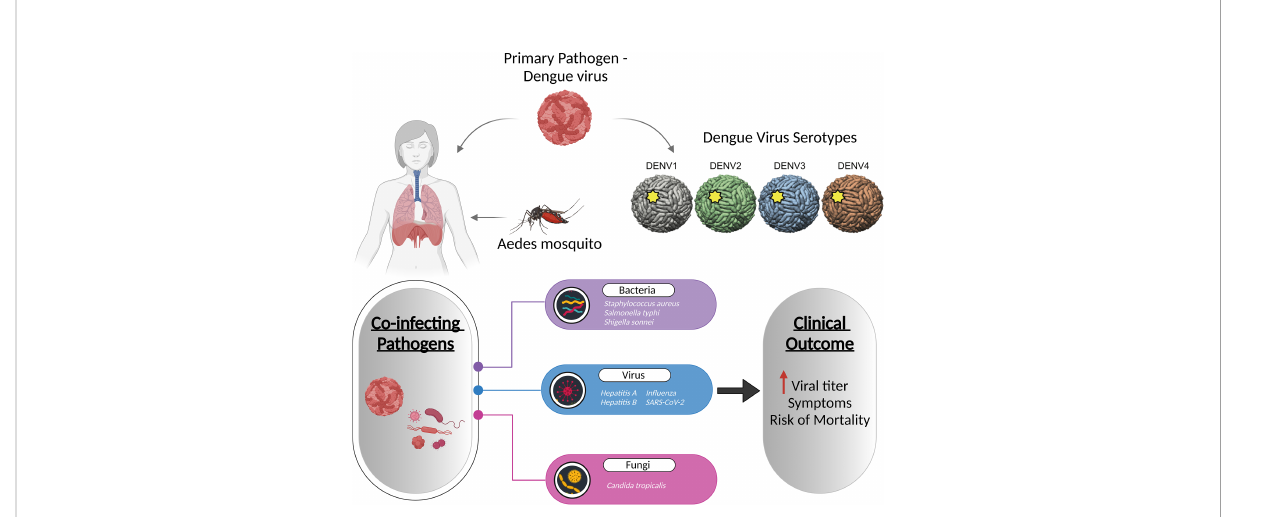
FIGURE 4 Co-infection of dengue with viruses, bacteria, and fungi increases the dengue viral titre, and even increases the symptoms and mortality of the disease. The fi gure depicts the known pathogens co-infecting along with the dengue virus and their association with disease